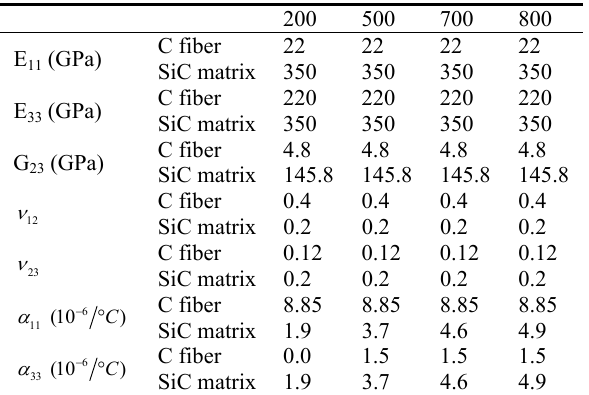
Table 1. Properties of the constituents